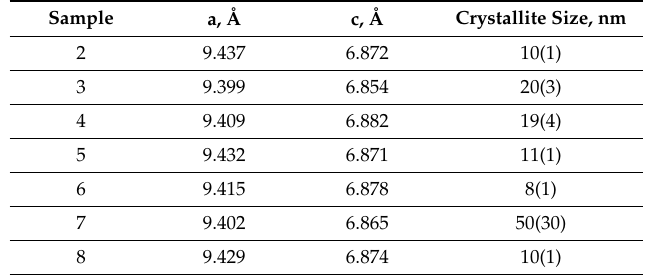
Table 3. Unit cell parameters of apatite from the studied urinary stones